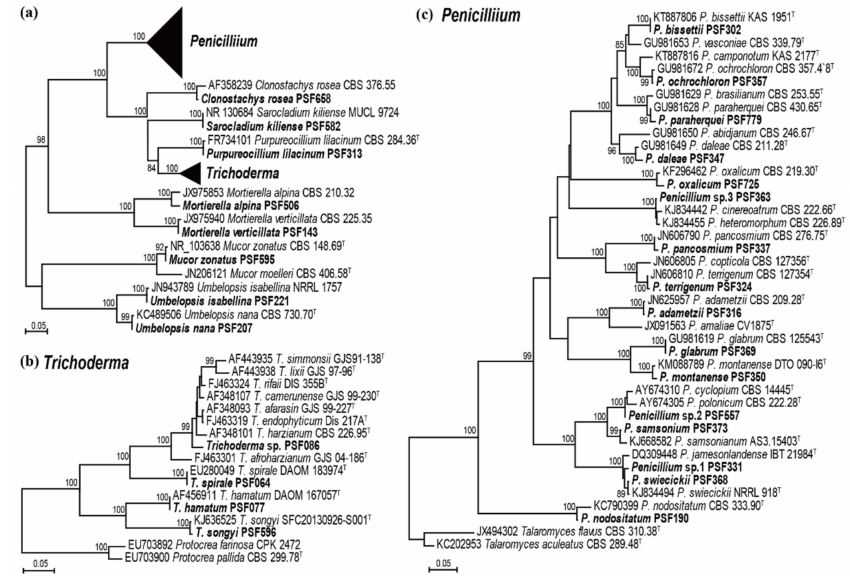
Figure 1. Diversity of microfungi isolated from soil within pine mushroom (PM) fairy rings. Phylogenetic tree based on ( a ) ITS sequences for all species, ( b ) tef1 α sequences for Trichoderma , and ( c ) benA sequences for Penicillium species. Phylogenetic trees were constructed based on the neighbor-joining method with the Kimura-2-parameter model and 1000 bootstrap replications. Bootstrap values ( > 70) are presented on the branch. “T” represents ex-type, and sequences generated in this study are in bold.